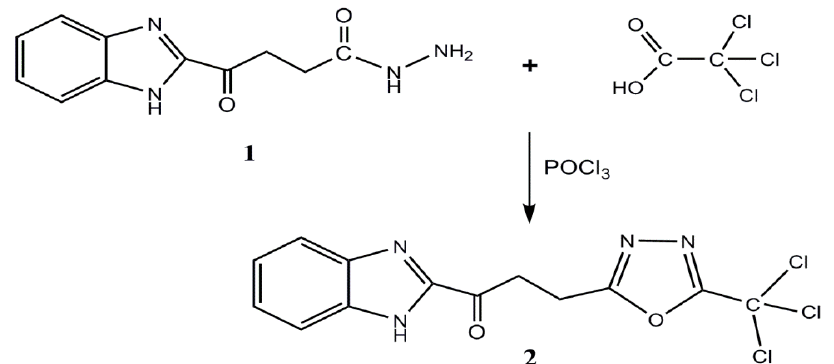
Figure 1. Synthetic route to the title compound 2